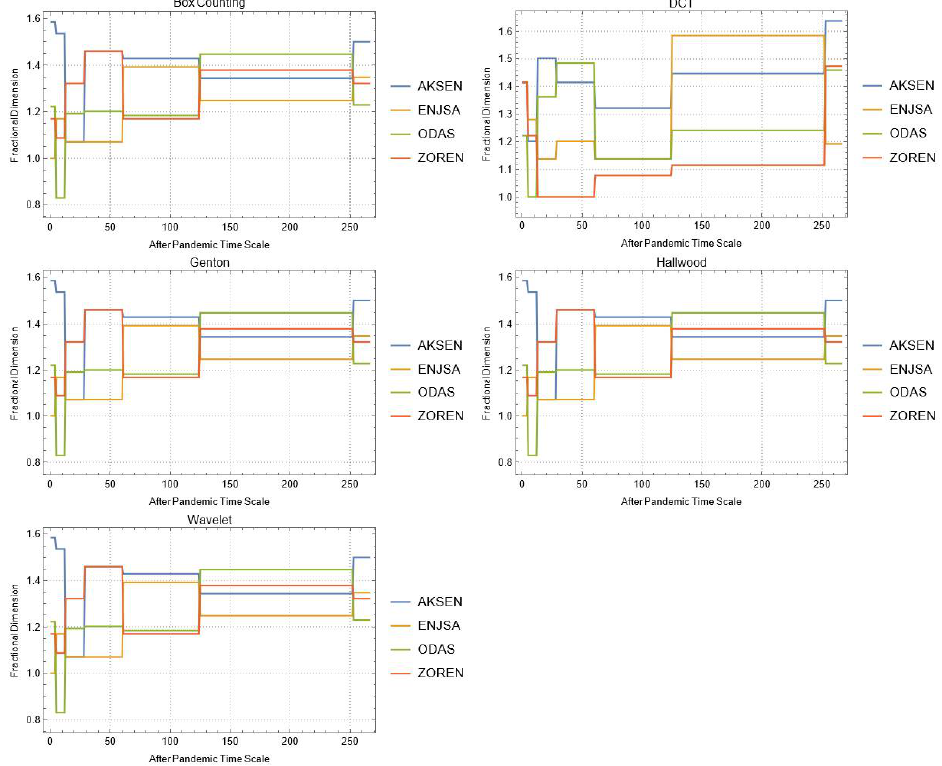
Figure A15. Daily changes of fractal dimensions after the pandemic (social).